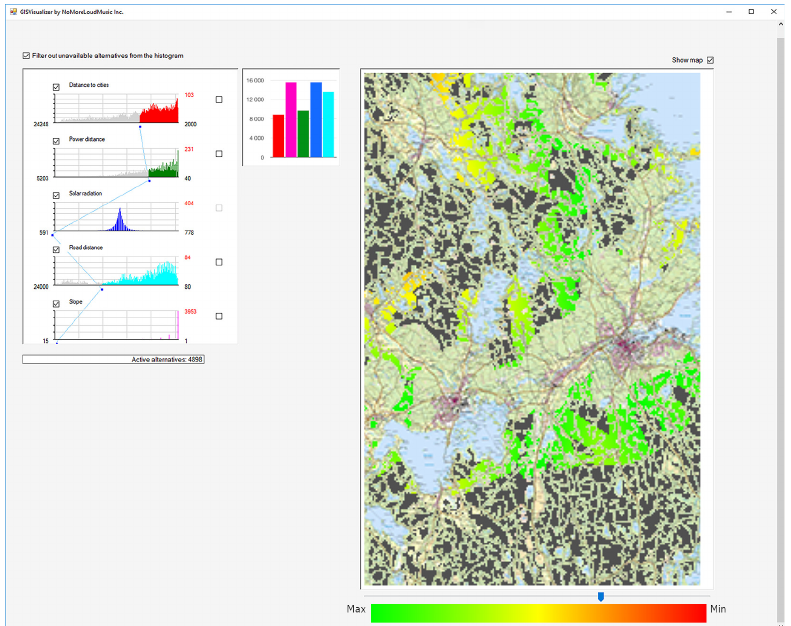
Figure 5. The main application window during the threshold adjustment process. The initial set of 15,555 alternatives is reduced to 4898, by adjusting the thresholds values for three criteria. The threshold for Distance to cities is increased to approximately 8500 m, the threshold for Power distance to approximately 1100 m, and the threshold for Road distance to approximately 14,000 m. The remaining acceptable alternatives are colour-coded based on the value in terms of Road distance , as it happens to be the criterion currently being